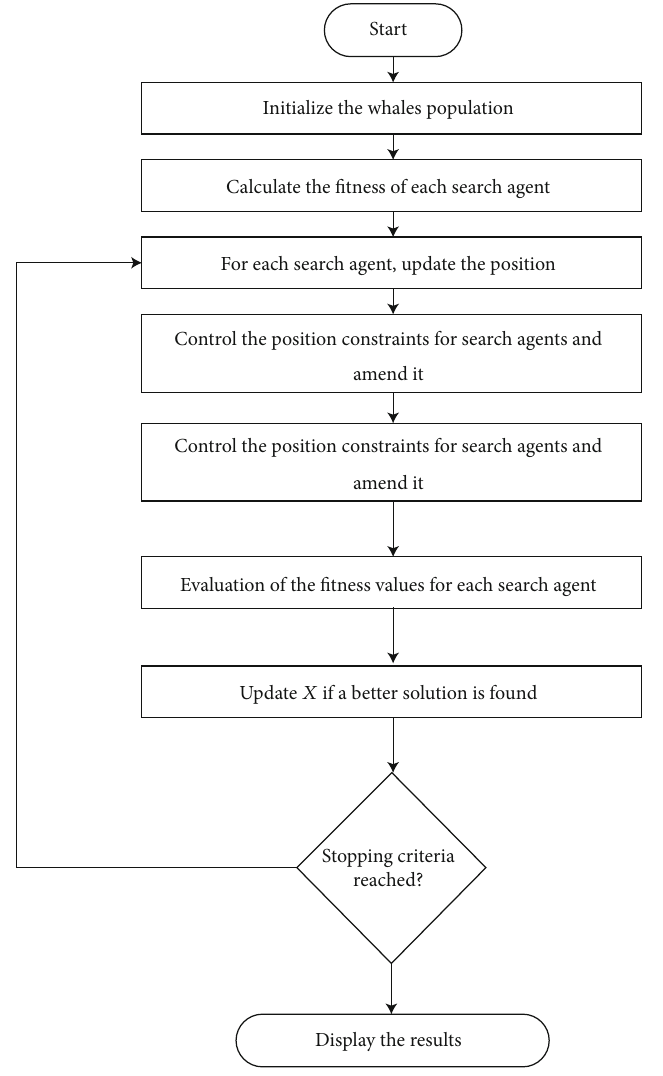
Figure 5: Flowchart of whale optimization algorithm.